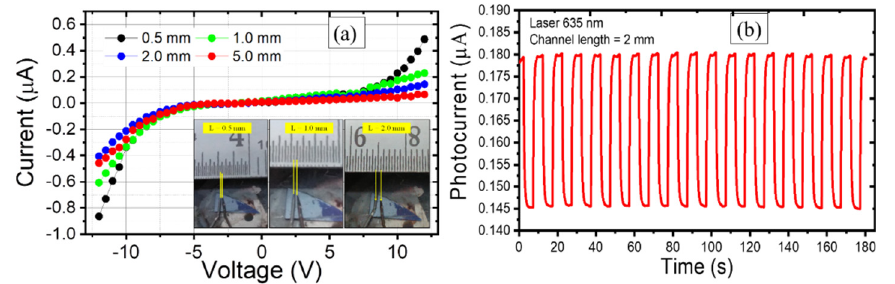
Figure 12. ( a ) Current vs. voltage characteristics at variable channel length and ( b ) photoconductive response under laser wavelength 635 nm.